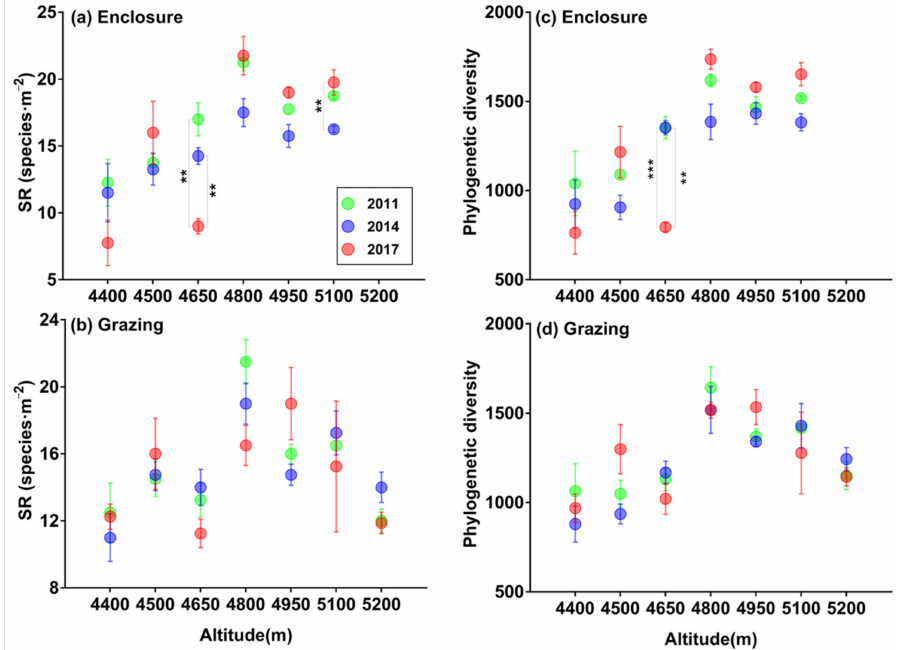
Figure 2. Dynamic variations of effects of enclosure and grazing on ( a , b ) species richness (SR) and ( c , d ) Faith’s phylogenetic diversity along the altitudinal gradient. Asterisk denotes significant difference in SR or phylogenetic diversity among different years. * P < 0.05, ** P < 0.01, *** P <